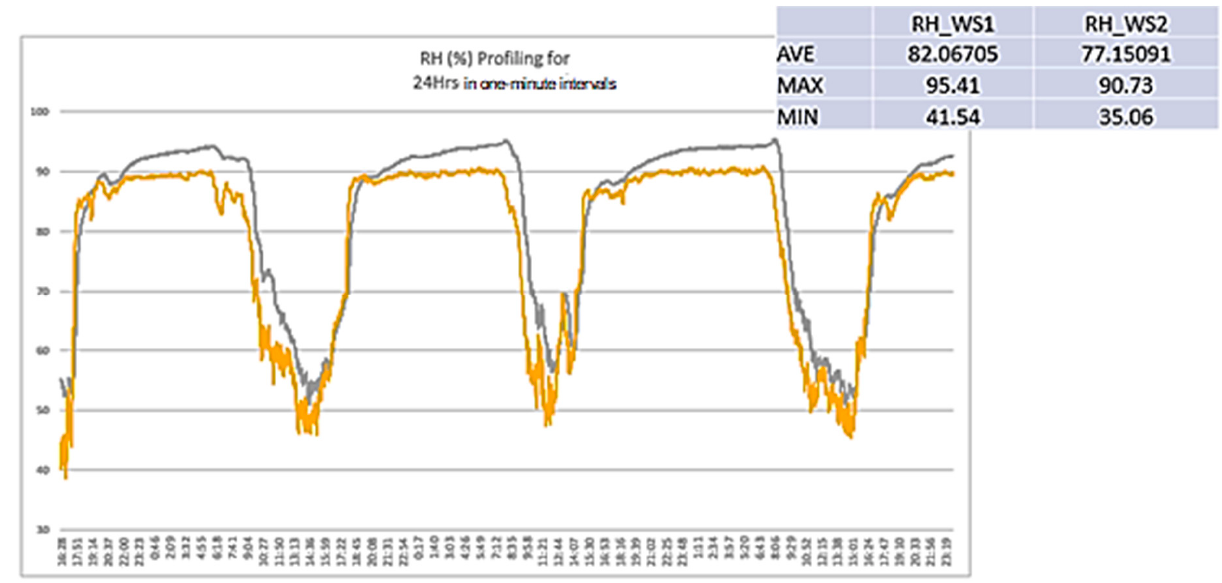
Figure 11. Relative humidity pro fi ling.